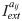
Network architecture, traveling waves and planning time.(a) Planning and readout network. For each neuron in the planning layer, 4 actions can be assigned. Actions neurons associated to planning neuron (i, j) are W
ij, E
ij, N
ij and S
ij which receive synaptic input respectively from the left, right, north, and south neighbor of the neuron (i, j) and evoke a motion in the same directions (just one synaptic input is shown). Action neurons corresponding to the current place of the agent (here again (i, j)) are driven by an additional input (Iextaij). The first of the 4 action neurons that is fired by the passing traveling wave inhibits the other 3 action neurons. (b) Synaptically propagating waves of activity from the goal neuron at (1,1) across a planning layer of 20 × 20 neurons, for four different obstacle configurations. Colors code for firing phases at steady state relative to the goal neuron. (c) Time courses of the local phase difference for two sample neurons at positions (10,10) and (20,20), indicated by □ and ○ in the top left panel of b, with their local west-positioned neighbors. The time to reach the maximal local phase difference represents the planning time for these two start positions towards the goal (here 600 and 1050 ms, vertical lines), and subsequently the full path towards the goal can be read out.